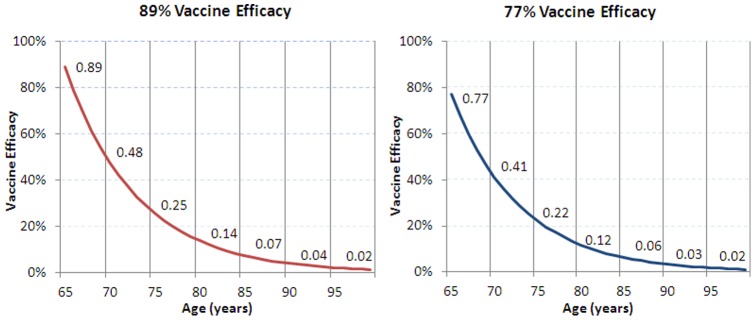

Tdap waning vaccine efficacy.